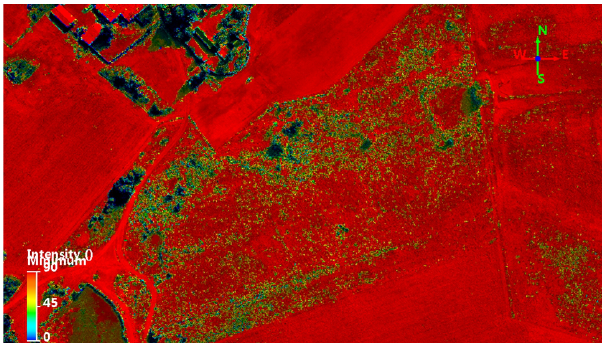
Figure 4. A minimum point intensity score of just below 45 (green coloration) correlated with areas with a relative surface